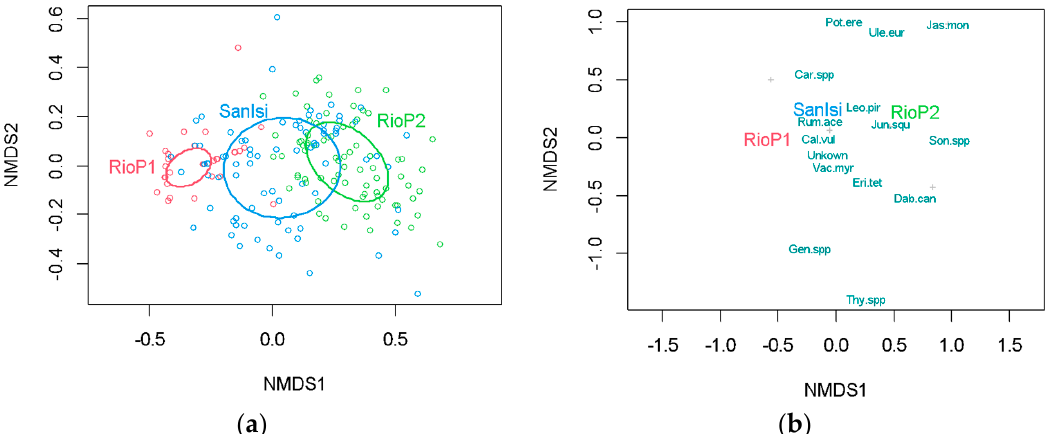
Figure 2. NMDS ordination for the first two axes of pretreatment soil seed bank compositional differences among the three heathlands before any treatment application in the Cantabrian Mountain range, illustrating: ( a ) Ordination biplot with deviational ellipses for the three sites; ( b ) species biplot where only species with high seed densities are shown. Less important species are represented as grey crosses. Species codes are: Cal.vul, Calluna vulgaris ; Car.spp, Carex spp.; Dab.can, Daboecia cantabrica ; Eri.tet, Erica tetralix ; Gen.spp, Genista spp.; Jas.mon, Jasione montana ; Jun.squ, Juncus squarrosus ; Leo.pir, Leontodon pyrenaicus ; Pot.ere, Potentilla erecta ; Rum.ace, Rumex acetosella ; Son.spp, Sonchus spp.; Thy.spp, Thymelaea spp.; Ule.eur, Ulex europaeus ; Vac.myr, Vaccinium myrtillus